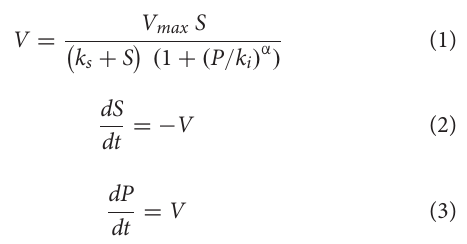
shown by the dots in Figure 7 . The D -allulose conversion yields of 97, 56, and 38%, from the initial allitol concentrations of 50, 150, and 250 mM, respectively, were obtained at 4 h of reaction with 1 mM Co 2 + added, which was about 1. 6-, 1. 7-, and 1.7-fold higher, respectively, than that without the Co 2 + addition. Then, kinetic modeling was made for D